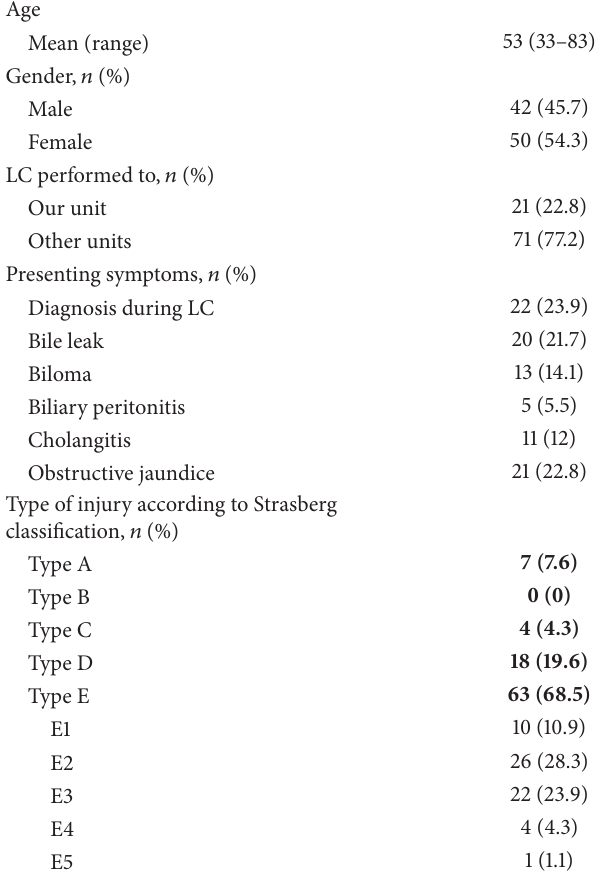
Table 1: Patients and BDI